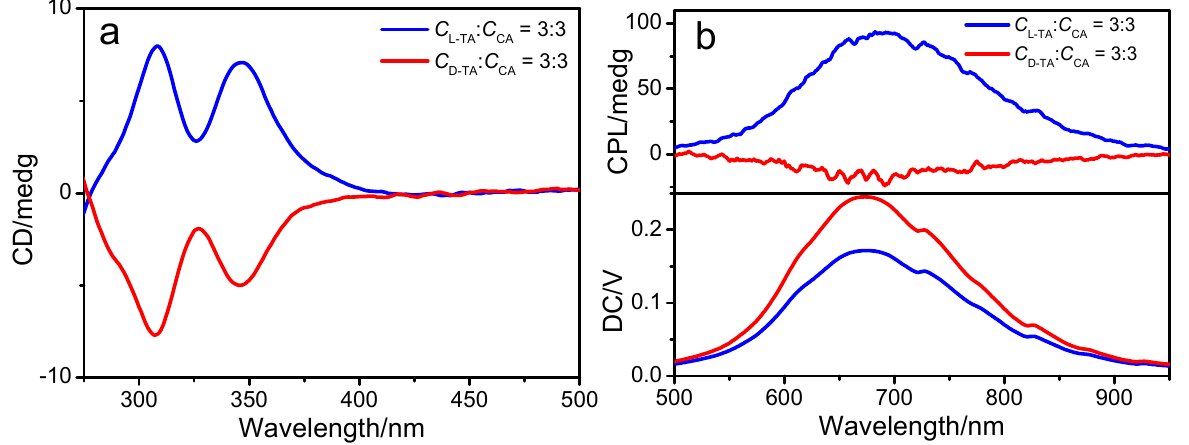
Figure 5. ( a ) CD spectra and ( b ) CPL spectra of L-TA/CA/DPT-AuNCs and D-TA/CA/DPT-AuNCs ( c TA = 3 mM; c CA = 3 mM).